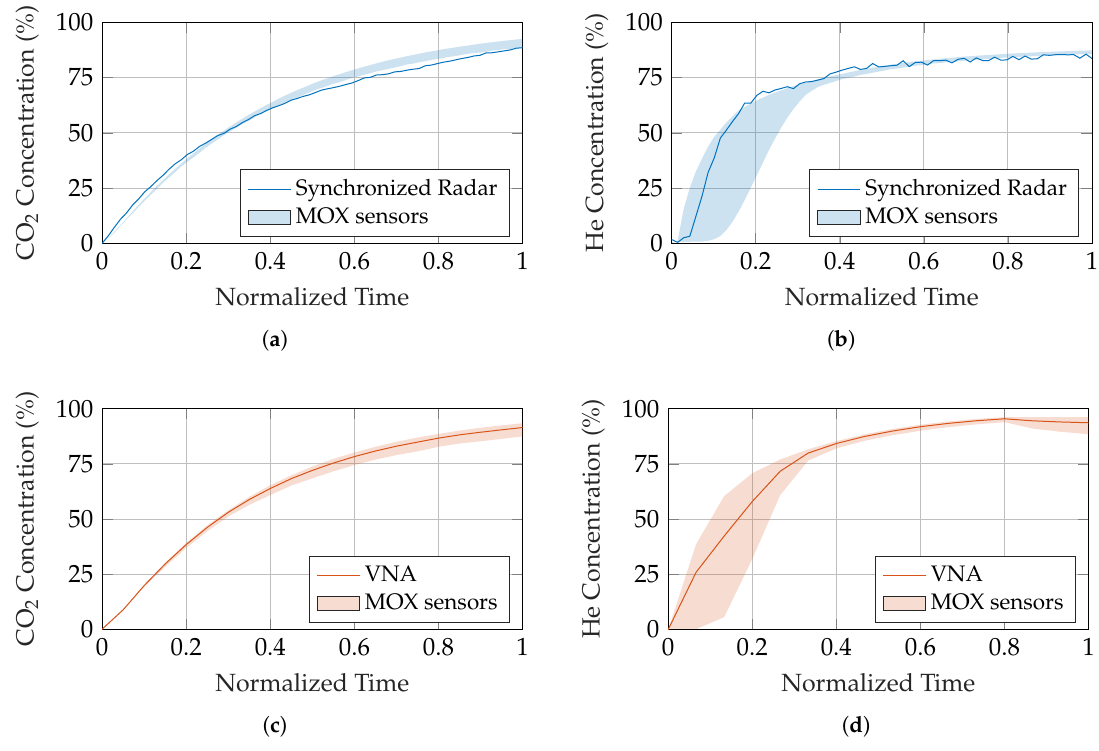
Figure 8. Increasing inclusion gas concentration during the filling process derived from relative TOF. Two measurement methods are shown in comparison to the estimated ground-truth boundaries obtained by MOX gas sensors. ( a , b ) Transmission measurement with two synchronized radar sensors; ( c , d ) S-parameter reference measurement with a commercial VNA. The results were generated in separate, consecutive runs, thus the filling process is not identical and the data is plotted